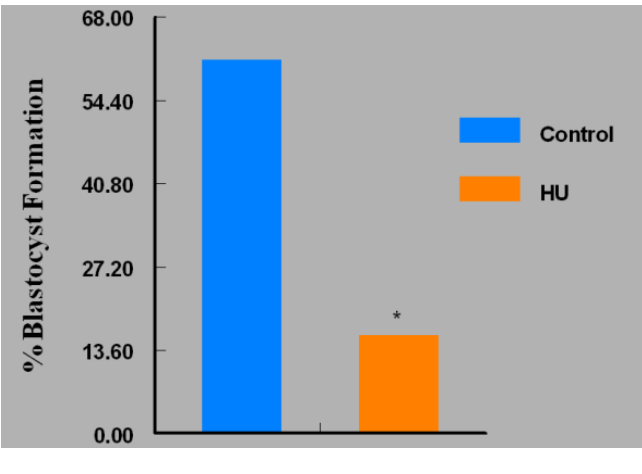
Figure 8. Effect of Intermittent in vitro Exposure of Embryos to Bioavailable HU (18 µg/mL) on Their Ability to Develop to Blastocyst Stage; n = 60 per Group. Results are expressed in percentages (HU = treated embryos; Control = vehicle treated embryos. Asterisks indicate a significant difference from controls ( P <